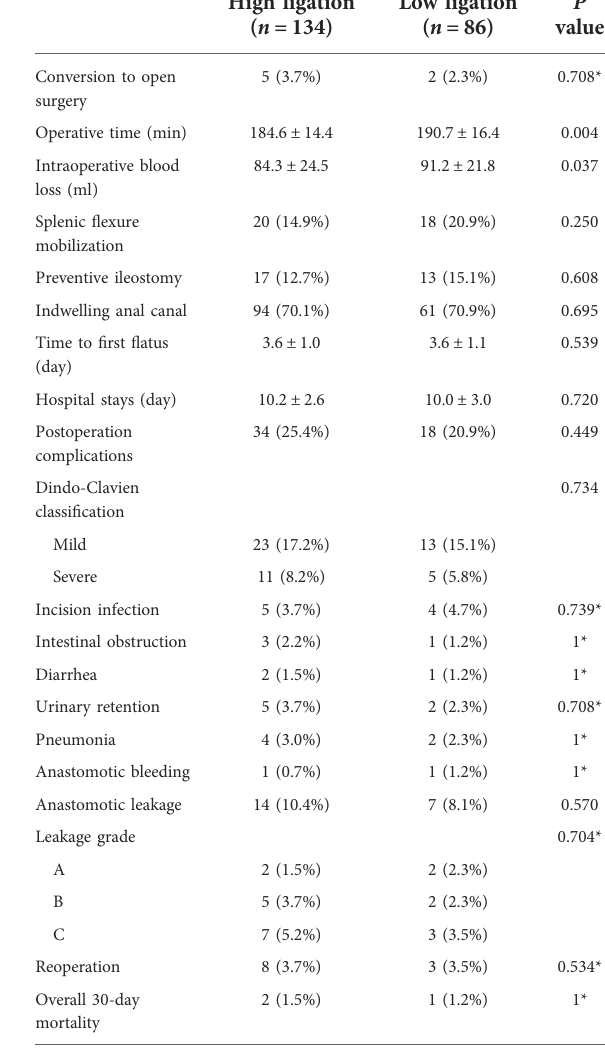
TABLE 2 Surgical data and postoperative